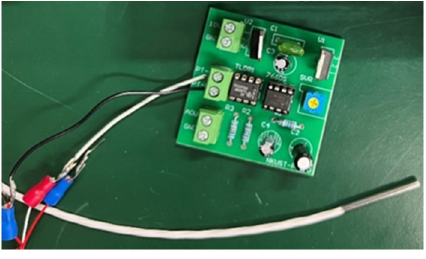
Figure 6. The Pt100 module.